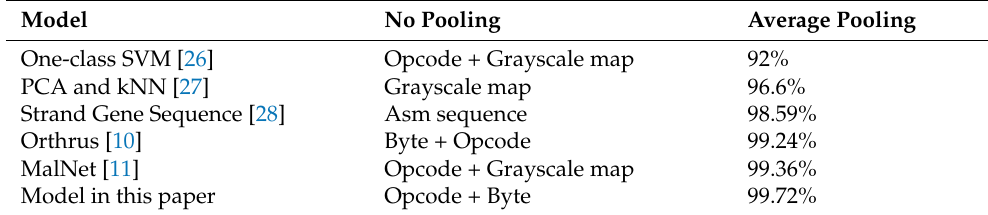
Table 8. 9-class-data dataset_model comparison.